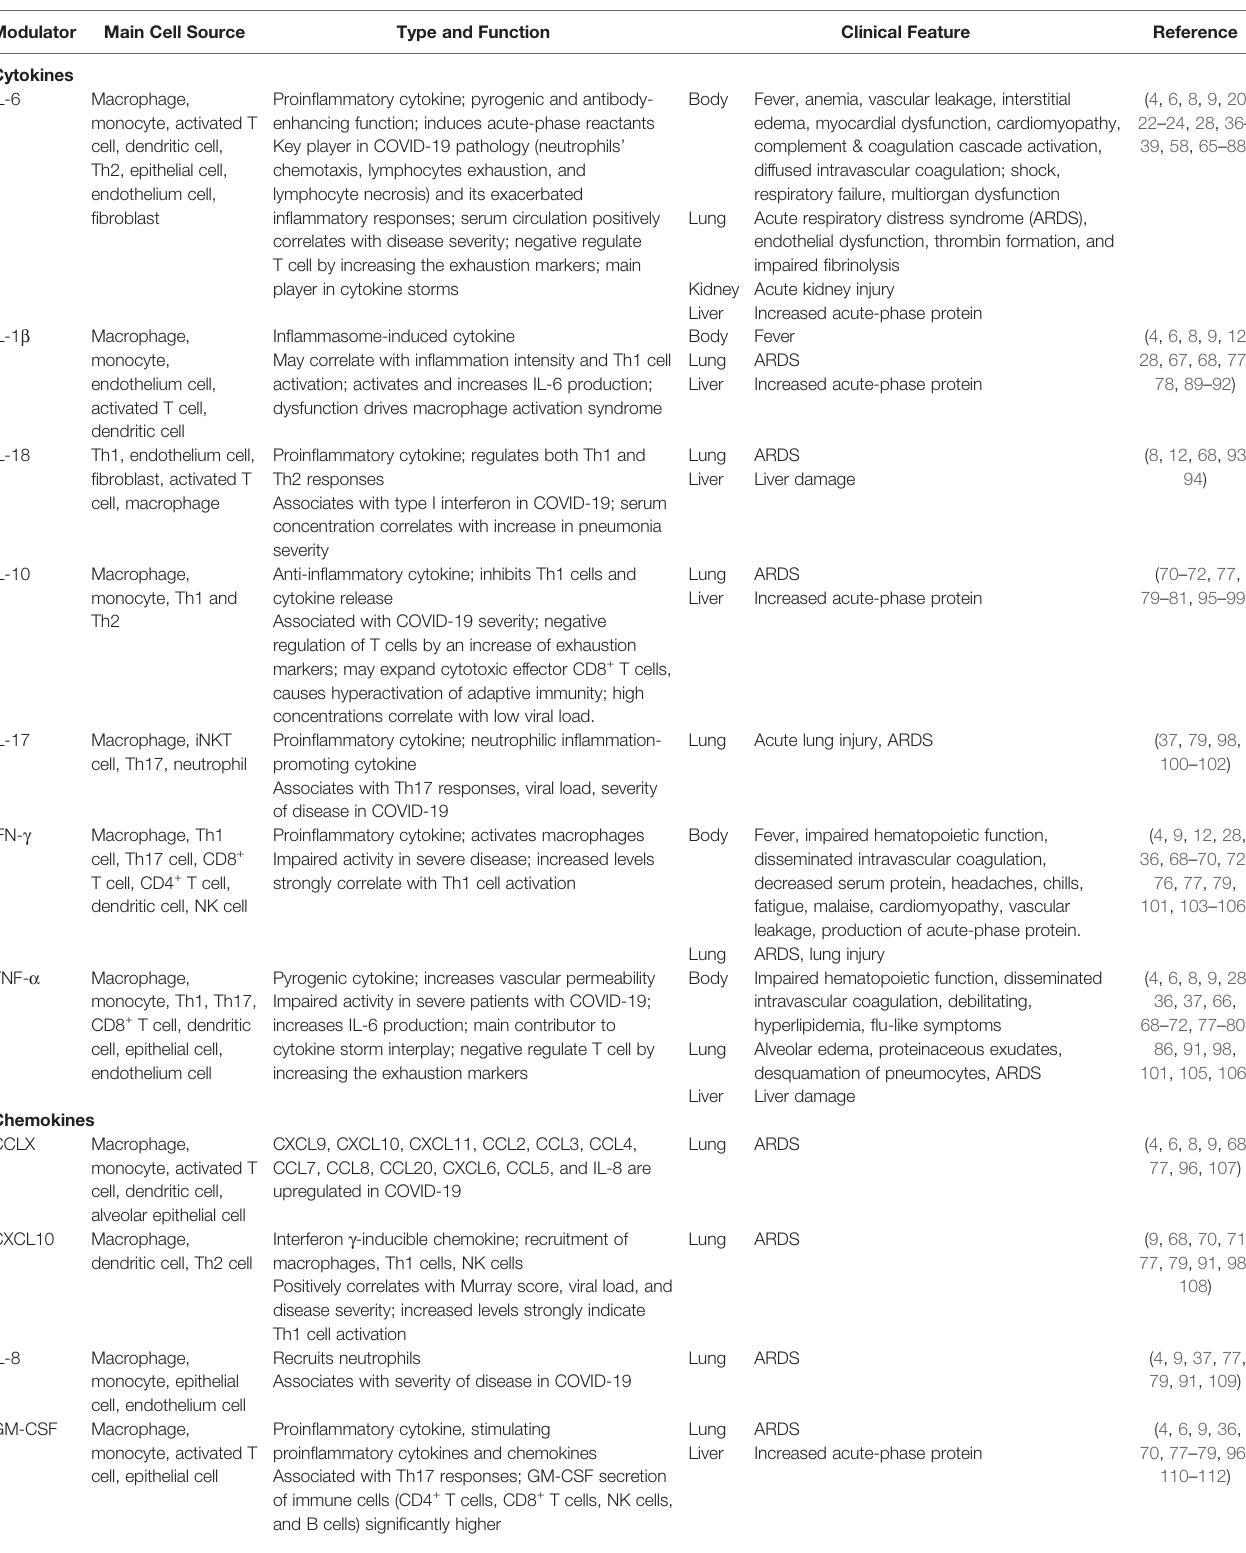
TABLE 1 | Representative of Histopathological Changes, Cytokine and Chemokine Secretions, and Cellular Origins in SARS-CoV-2